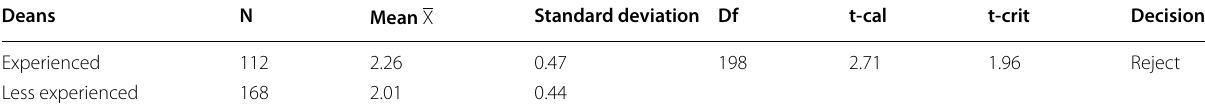
Table 6 Test for significant difference in experienced and less experienced university Deans’ cognizance of non-violent discipline control strategies that sustain quality